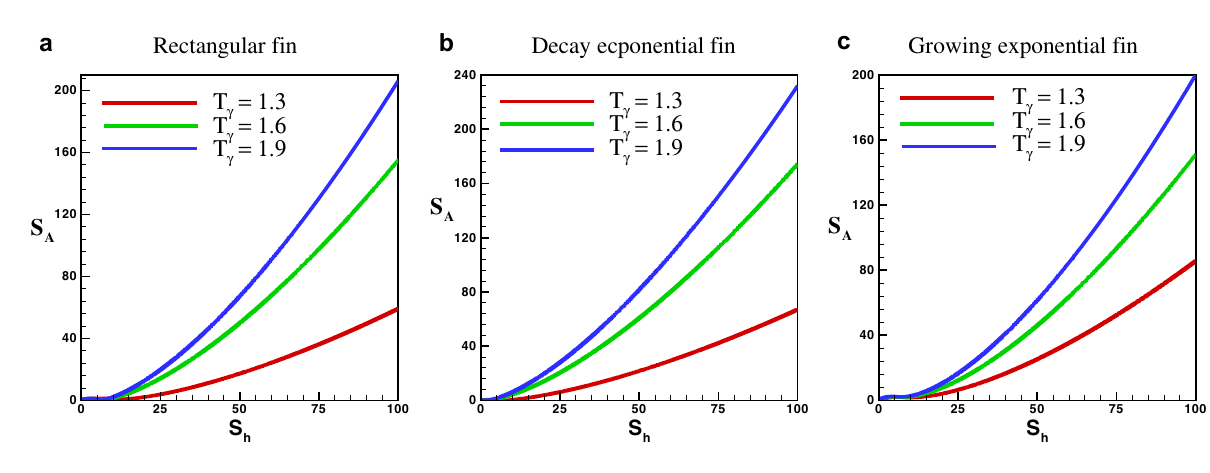
Figure 10. Average entropy for various fins